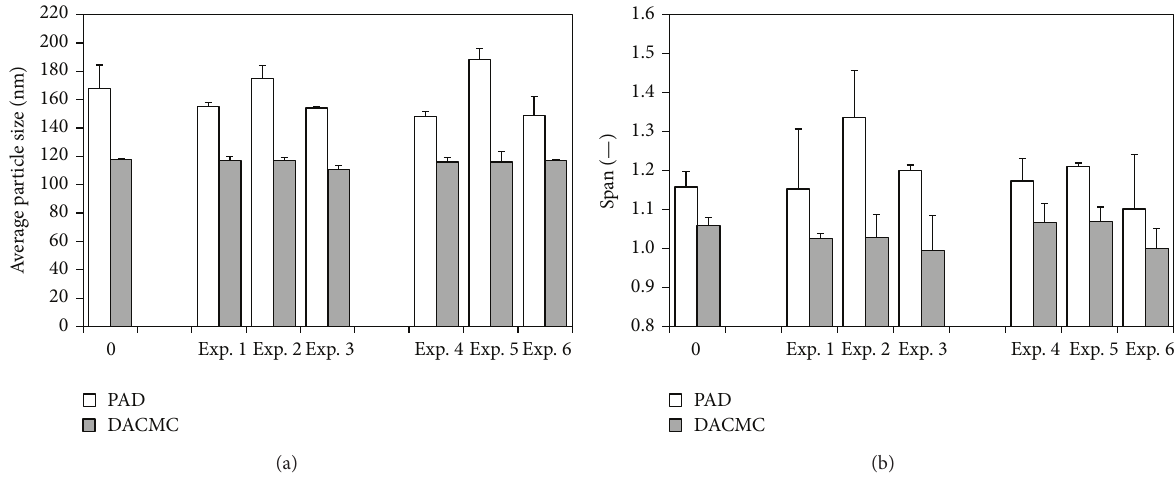
Figure 8: Average size (a) and span of the distribution (b) for nanoparticles obtained after reconstitution of spray dried powders with water at room temperature. Sample “0” denotes the original nanosuspensions (precursors). Error bars indicate the standard